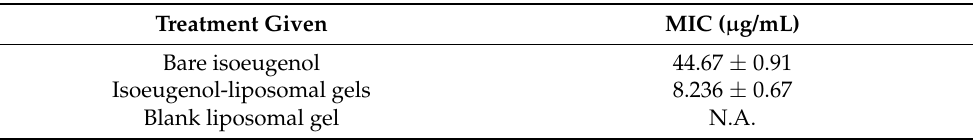
Table 2. MIC of the bare isoeugenol, isoeugenol-liposomal gel, and blank gel against MRSA. Study is performed in triplicates, and all data are expressed as the mean ± standard